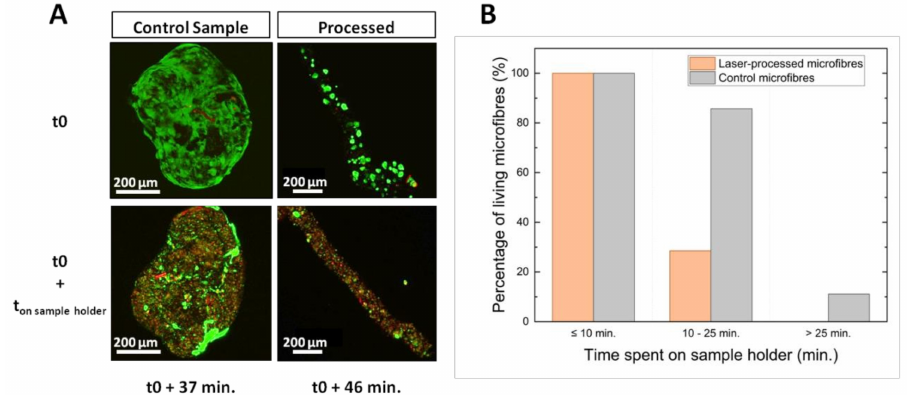
Figure 5. Evolution of cellular viability according to microfibre hydration. ( A ) Confocal microscope images of two microfibres (one control microfibre and one laser-processed microfibre) stored in culture medium (t0) and the same microfibres 37 and 46 min after the culture medium was removed. Only the processed microfibre received laser treatment. ( B ) Histogram showing the percentage of microfibres still alive after 24 h as a function of the time spent on the sample holder with only a small amount of culture medium for the group of laser-processed microfibres (orange) and the group of control microfibres